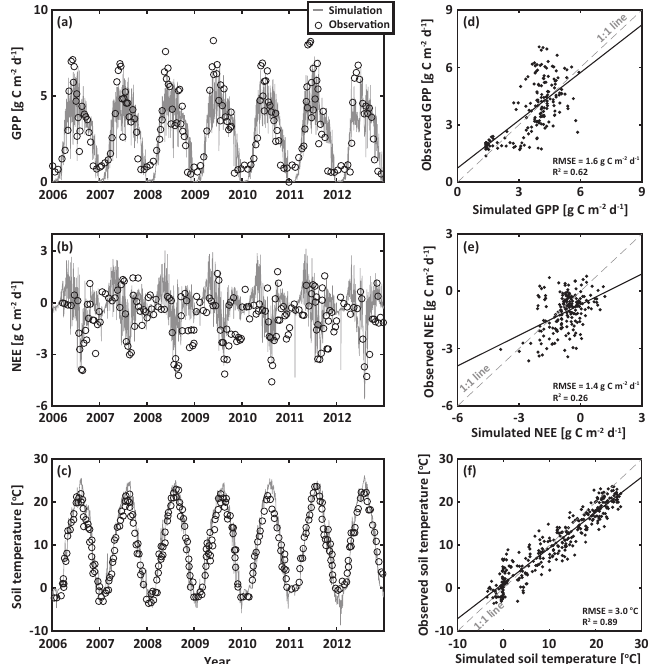
Figure 2. Model validation: ( a ) predicted (gray lines) and observed (circles) GPP (RMSE = 1.6 g C m − 2 d − 1 ), ( b ) NEE (RMSE = 1.4 g C m − 2 d − 1 ), and ( c ) soil tmperature to a depth of 0.15 m (RMSE = 3 ◦ C) during the model validation period from 2006 to 2012. The corresponding results were presented in ( d – f ), respectively. The gray dashed line in ( d – f ) represents the 1:1